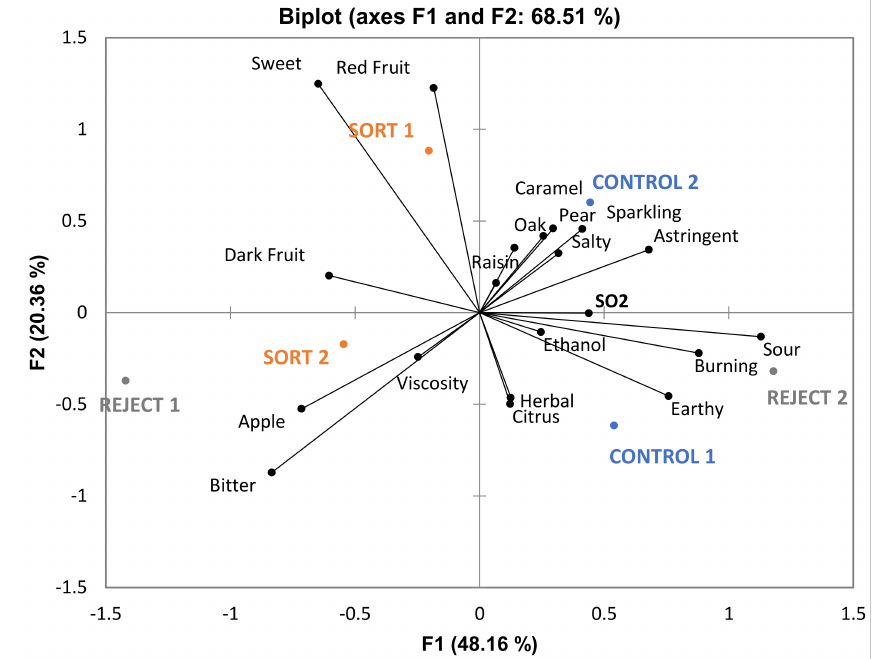
Figure 4. Biplot PCA of Grenache wines generated by descriptive sensory analysis. Significant attributes are given in bold ( n = 11, p < 0.05).